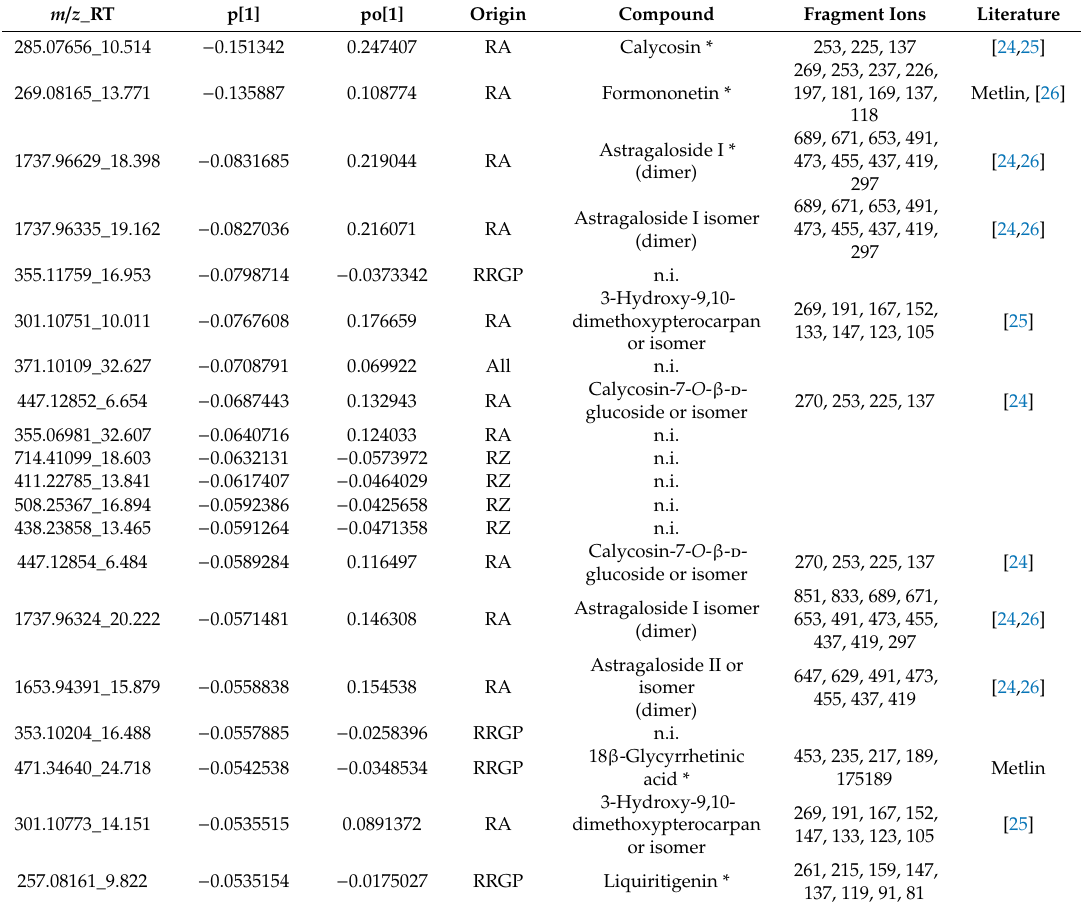
Table A2. Hits for the inhibitory activity of HQJZT against TNF- α production.